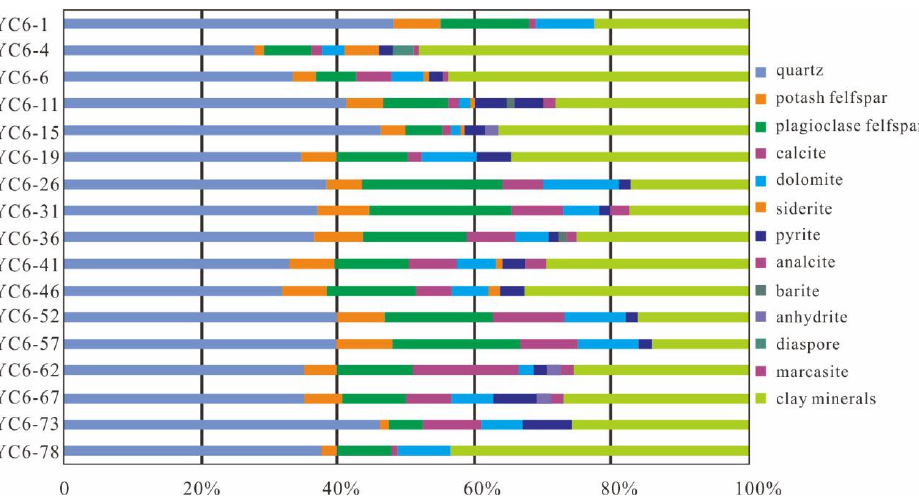
Figure 3. Mineral composition of shale reservoir in Well Yucan-6 (XRD).